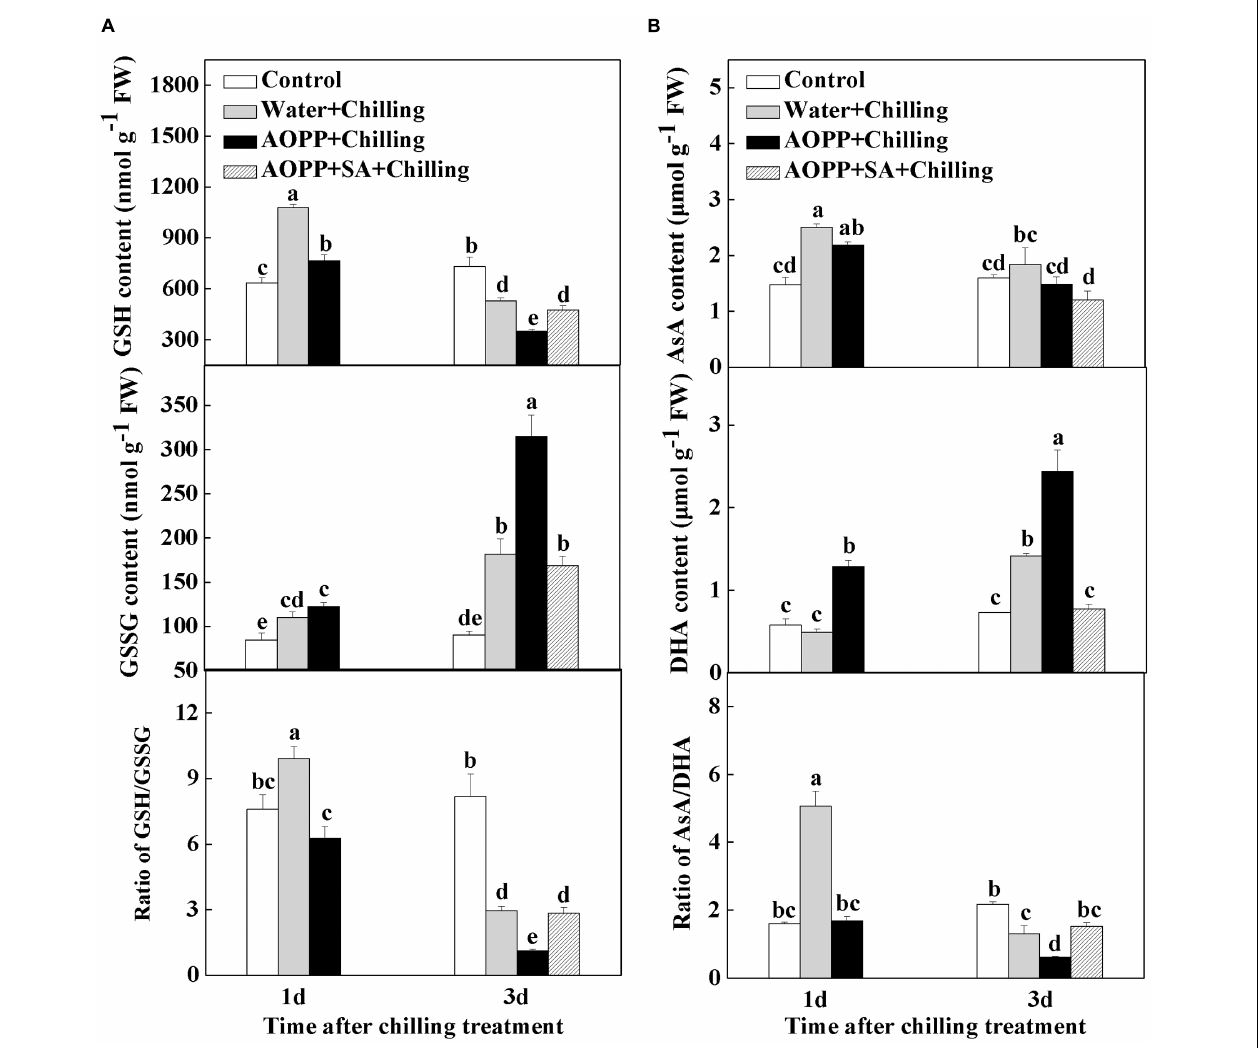
FIGURE 6 | The effects of chilling and SA on glutathione (A) and ascorbate (B) redox status in watermelon plants. Water, plants sprayed with distilled water; AOPP, plants treated with 50 µ M AOPP; AOPP + SA, plants pretreated with 50 µ M AOPP for 1 day before chilling stress and then 10 µ M SA after 1 day of chilling stress. Leaf samples were collected at the indicated times. The data are the means of four replicates with SEs. Different letters indicate significant differences between the treatments according to Tukey’s test ( P <